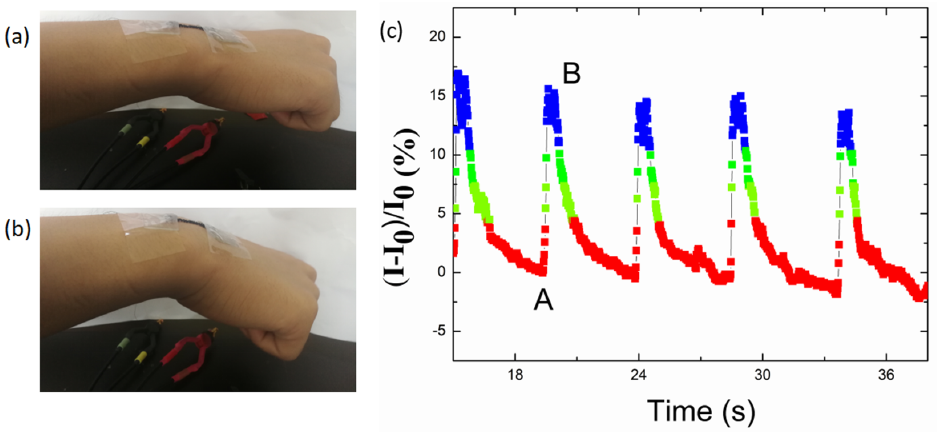
Figure 10. ( a ) Photograph of the TPU/graphene strain sensor with an intertwined-coil configuration attached on a volunteer’s wrist, in the initial state. ( b ) Photograph of the TPU/graphene strain sensor with an intertwined-coil configuration attached on a wrist in the bending state. ( c ) Sensing performance of the TPU/graphene strain sensor with an intertwined-coil configuration for a given bending degree of the wrist.